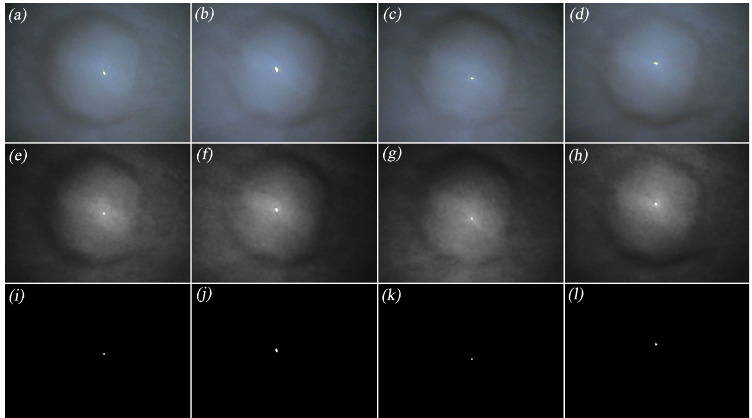
Figure 12. Photometric stereo images, illuminance maps, and detected specular highlight regions in the experiment. ( a – d ): captured photometric stereo images (after distortion correction). ( e – h ): illuminance maps of photometric stereo images in the experiment. ( a – l ): detected specular highlight regions in the